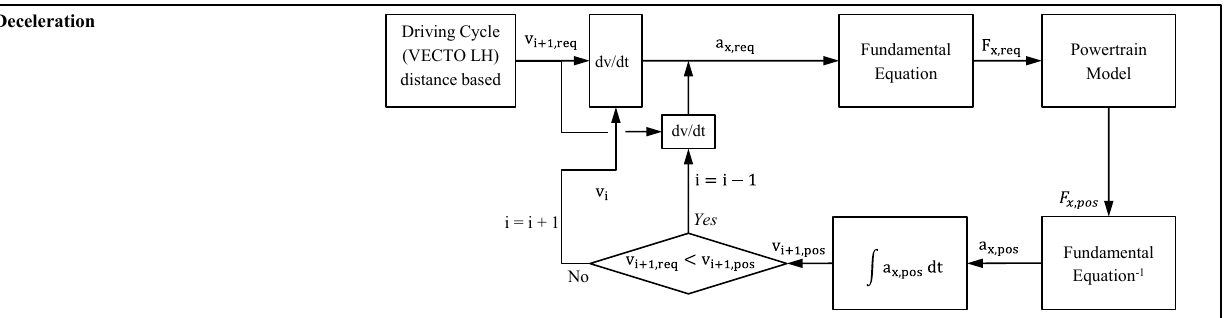
Figure A2. Simulation step of the detailed driving simulation in case of deceleration.